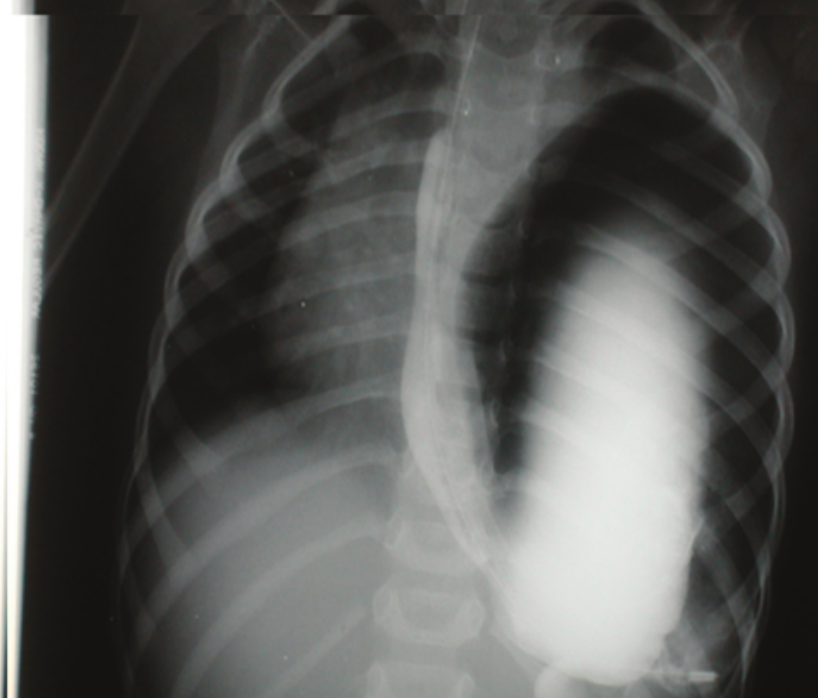
Figure 2: CXR with contrast before